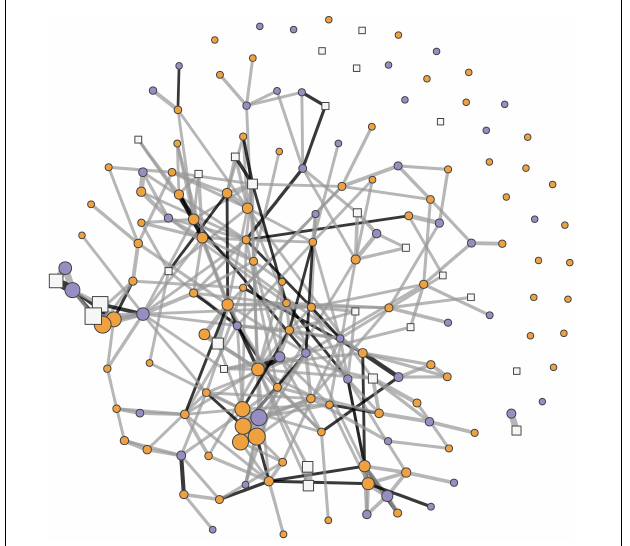
FIGURE 2 | A social network depicting all the (overall) social associations between Tree Skinks ( Egernia striolata ) in our Albury, NSW population over two active seasons (2014–2016). Adults are represented with circles (orange are female, and purple are male), and juveniles are represented with white squares. The size of nodes reflects an individual’s weighted degree (i.e., the strength of their social associations or HWI). The thickness of connecting lines (edges) correspond to the HWI values (i.e., the strength of associations between skinks). Genetic relatedness estimates of more than 0.125, representative of at least first cousins, are depicted with black lines (edges), and all other lines are gray.